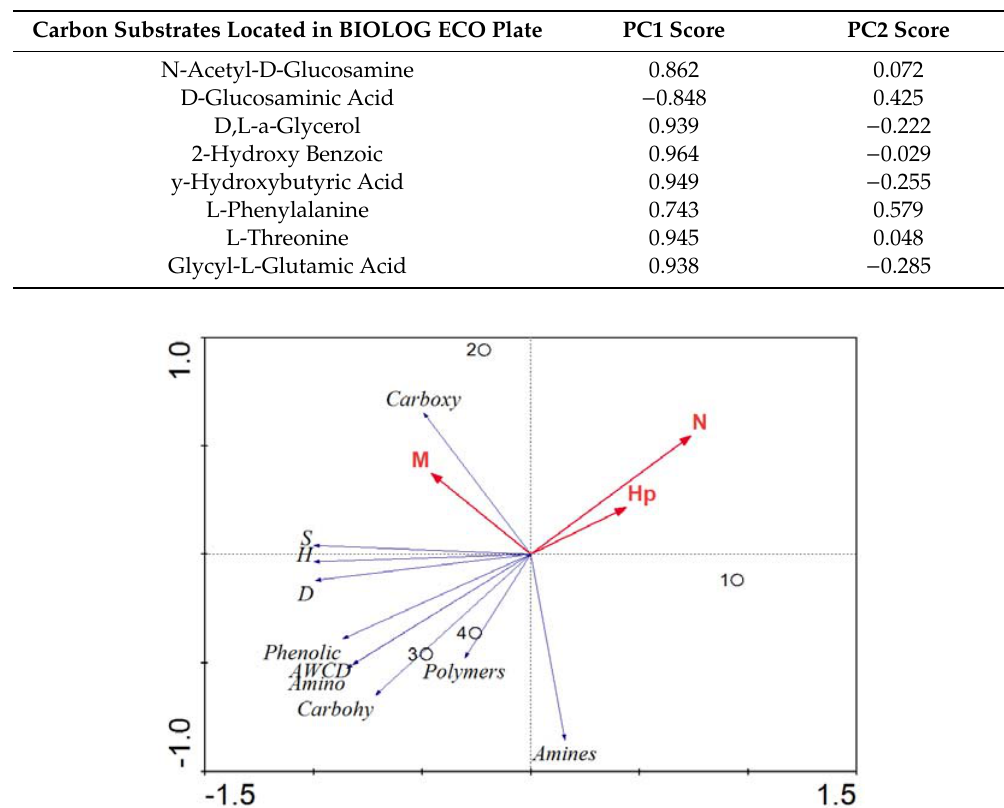
Figure 5. Redundancy analysis (RDA) ordination tri-plots of the phytoplankton community and the associated bacterial community metabolic fingerprints. N represents the cell abundance of phytoplankton, M represents the relative abundance of Melosira , Hp represents Shannon–Wiener index of phytoplankton. AWCD is average well color development. H , S and D are the associated bacterial community diversity indexes. Amino, Amines, Polymers, Phenolic, Carbohy and Carboxy represent amino acids, amines, polymers, phenolic compounds, carbohydrates and carboxylic acids, respectively. 1, 2, 3 and 4 represent 0, 5, 18 and 38 d, respectively.